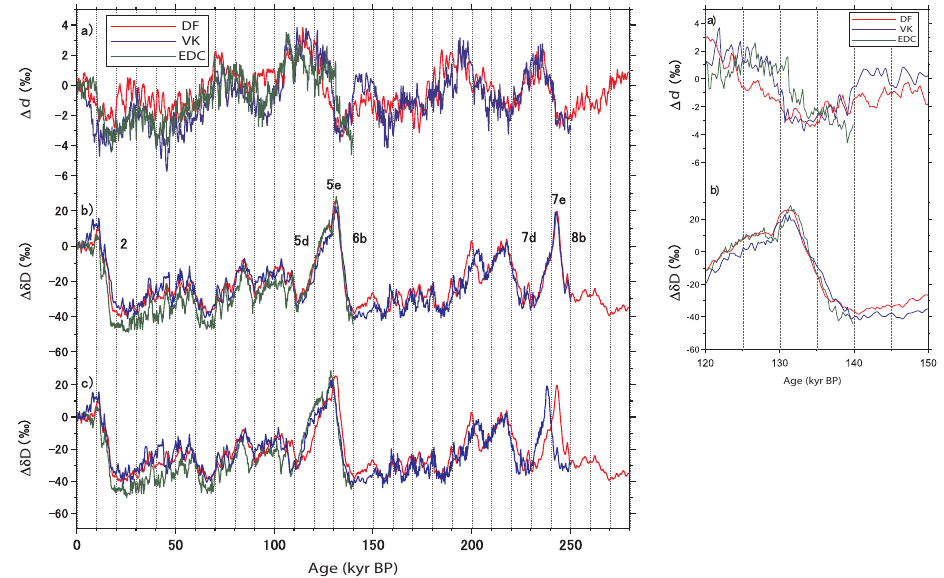
Fig. 3. δ D and deuterium-excess records from the DF ice cores. Left panel: (a) Deuterium-excess ( d) records from DF (red line), Vostok (blue line), and EDC (green line) cores plotted on the O 2 /N 2 orbital age scale for DF. (b) δ D records of the three cores plotted on the O 2 /N 2 orbital age scale for DF. (c) δ D records of the three cores plotted on the original age-scales (see text). Numbers indicate corresponding Marine Isotope Stage (MIS) (Tzedakis et al., 2004). Right panel: enlarged view of Termination II. All the isotope ratios are expressed as the deviations ( 1 ) from the present (past 2kyr average)